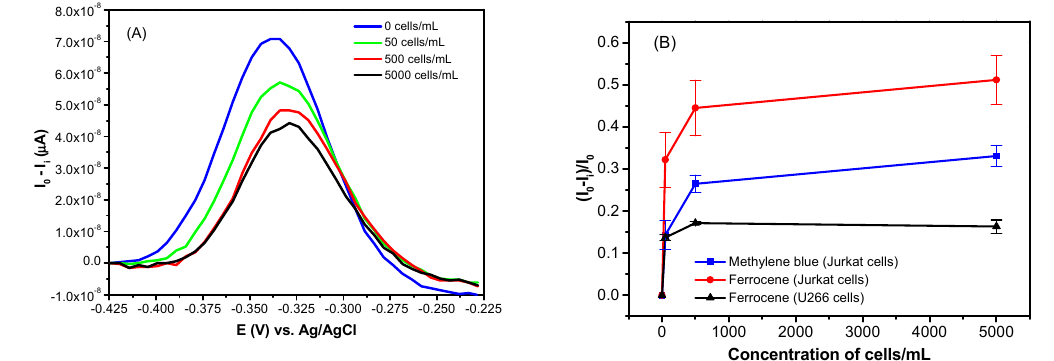
Figure 8. ( A ) Differential pulse voltammograms of methylene blue modified aptamer at different Jurkat cell concentrations in working buffer at pH 7.4. ( B ) The relative changes of the peak current intensity of the two types of electrochemical aptasensors vs. cell concentration. I 0 is peak current prior to addition and I i after addition of the cells in respective concentrations. Partially adapted from [106].